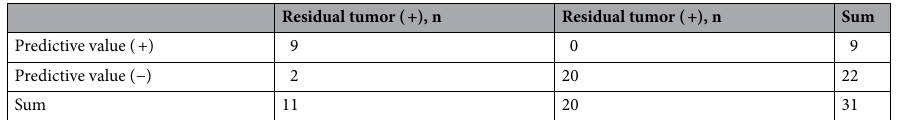
Table 4. Correlation between positive and negative predictive values of combination of HVA and VMA and the presence or absence of a residual tumour.